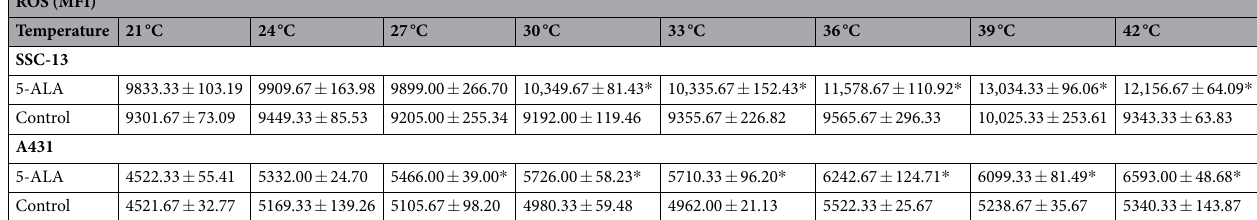
Table 4. ROS generation of 5-ALA and control samples incubated at variable temperatures. Abbreviations: 5-ALA – 5-aminolevulinic acid, ROS – Reactive Oxygen Species, MFI – Median Fluorescent Intensity. P < 0.05 denoted by asterisk ( * ).